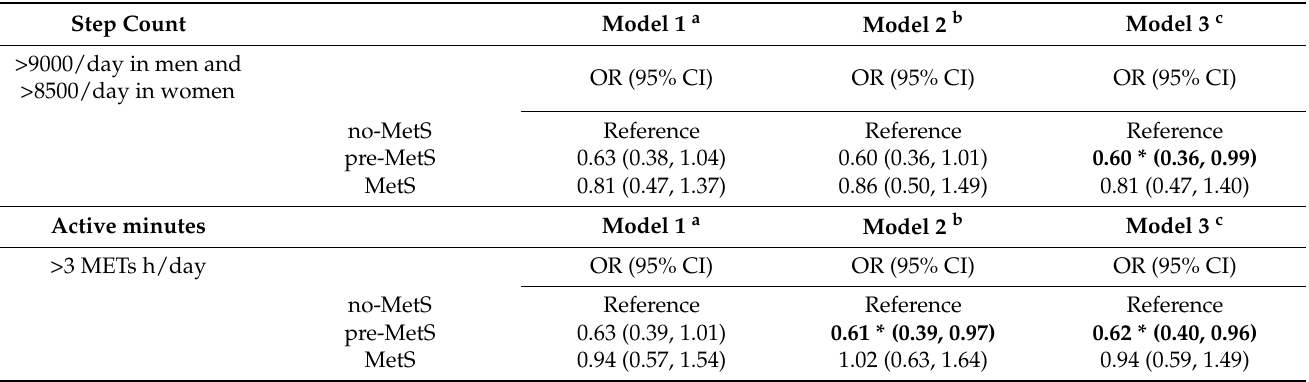
Table 2. Odds ratios of achieving the recommended physical activity level by metabolic syndrome status ( n =